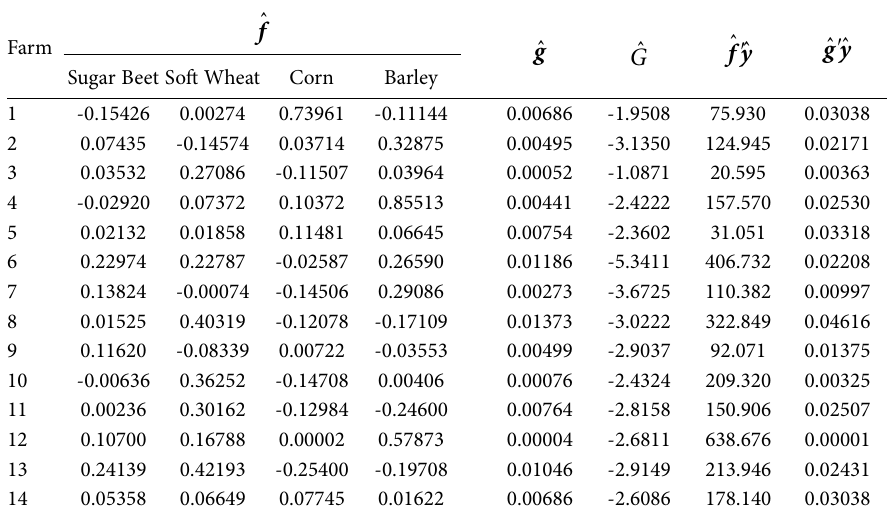
Table 10. Intercepts f ˆ , g ˆ and G ˆ matrix of the marginal cost and input demand functions for the case of zero production of some crop in various farms.